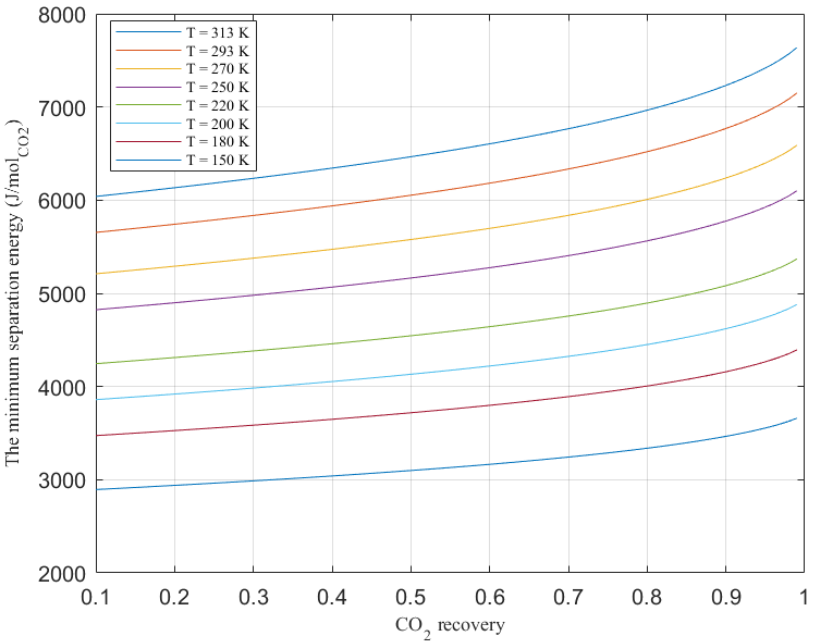
Figure 8. Minimum energy for separation of CO 2 from a gas mixture for different temperatures and CO 2 recovery values when the CO 2 mole fraction is 13%.